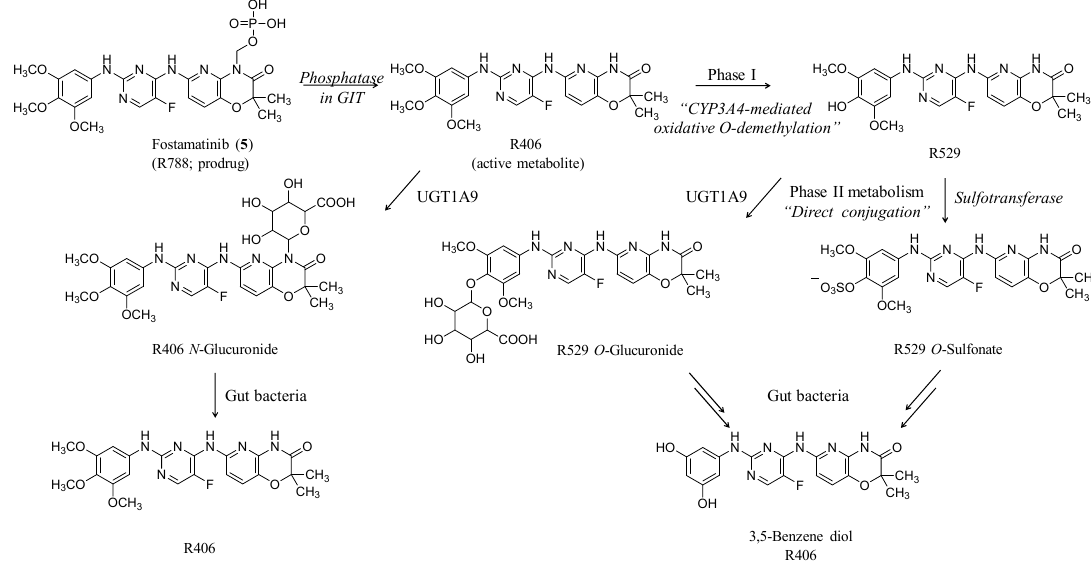
Figure 4. Structural representation of fostamatinib ( 5 ) which has a central domain of fluorinated amino-pyrimidine that is substituted from one side by trimethoxy aniline and from the other side with dimethyl-pyrido-oxazinone. The latter is the site at which the prodrug moiety is installed. Fostamatinib is metabolized in the gut by alkaline phosphatase to R406 which is the active metabolite. R406 is extensively metabolized, primarily via oxidative O-demethylation (phase I metabolism) and N- or O-glucuronidation (phase II metabolism). No reports describe the pharmacological activity of other metabolites.